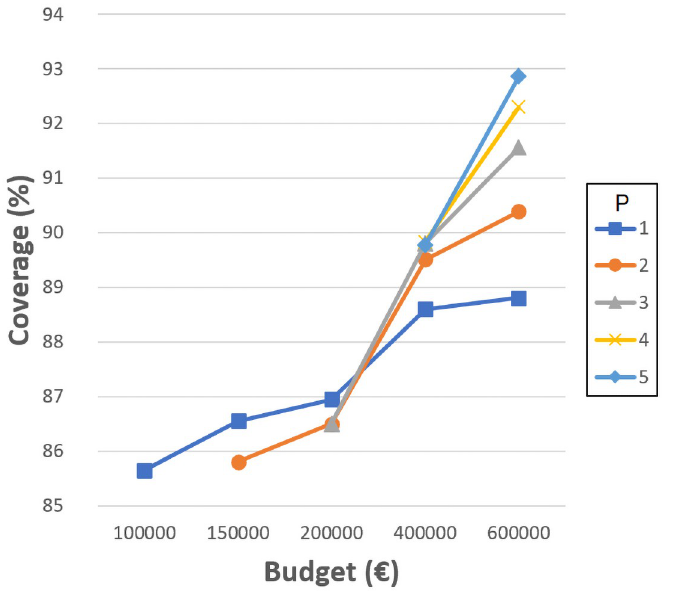
Fig 4. Coverages for 1000